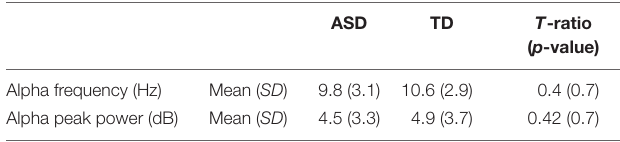
TABLE 3 | Alpha waves characteristics (Matlab 2014 –